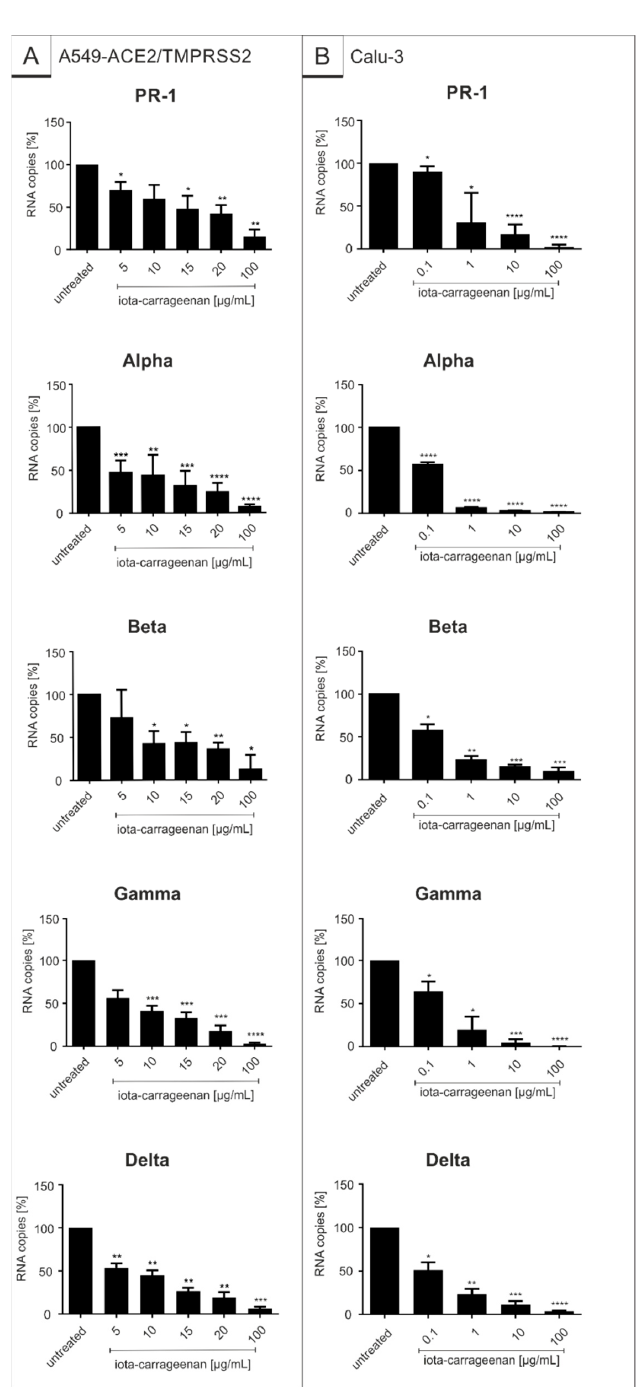
Figure 2. Iota-carrageenan inhibits replication of SARS-CoV-2 PR-1 and the VOCs Alpha, Beta, Gamma and Delta with comparable efficacy. A549-ACE2/TMPRSS2 ( A ) and Calu-3 cells ( B ) were infected with either SARS-CoV-2 PR-1 , Alpha, Beta, Gamma or Delta at a MOI of 2 × 10 − 2 . At 1 h after infection and removal of input virus, cells were treated with indicated concentrations of iota-carrageenan. Cell culture supernatants were harvested at 3 days post infection (dpi). The virions were purified and analyzed by q-RT-PCR. Data represent means of 6 ( A —Alpha), 4 ( B —PR-1) or 3 ( A —PR-1, A —Beta, A —Gamma, A —Delta, B —Alpha, B —Beta, B —Gamma, and B —Delta) independent experiments ± standard deviation (* p < 0.5, ** p < 0.01, *** p < 0.001, and **** p < 0.0001) using a one sample t test, where each value is compared to the untreated control. The absolute values of conducted qRT-PCR analysis are included in Supplementary Table